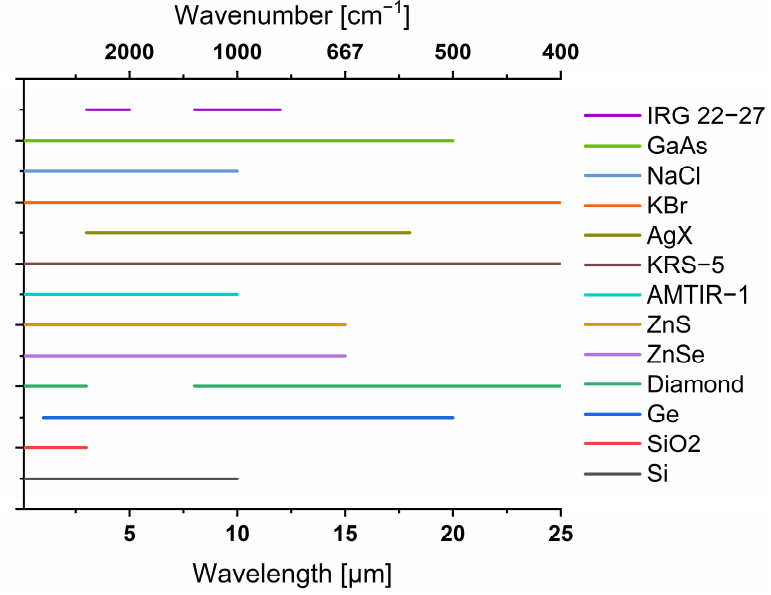
Figure 6. Spectral transparency range of selected materials used for waveguiding applications in the infrared.